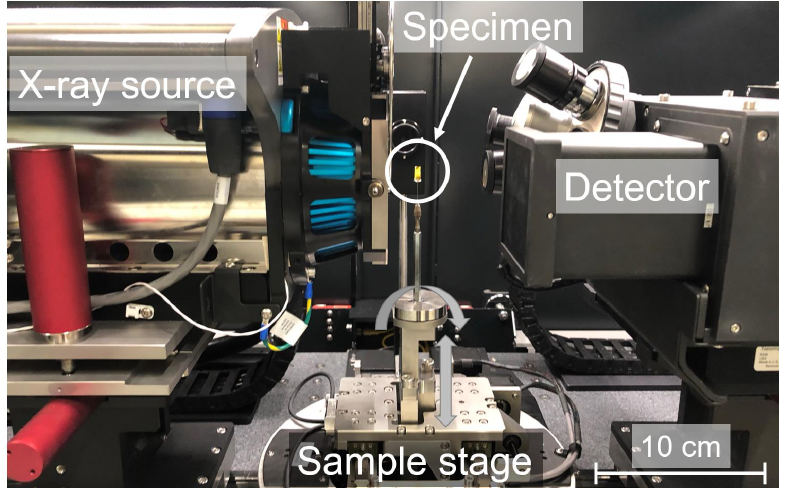
Figure 6. Picture of the Zeiss Versa 520 µ-CT. On the left side the X-ray source is located, on the right side the digital detector and in the center the sample holder which can be rotated both in height and axially. The specimen (oil loaded filter material) is attached on top of the sample